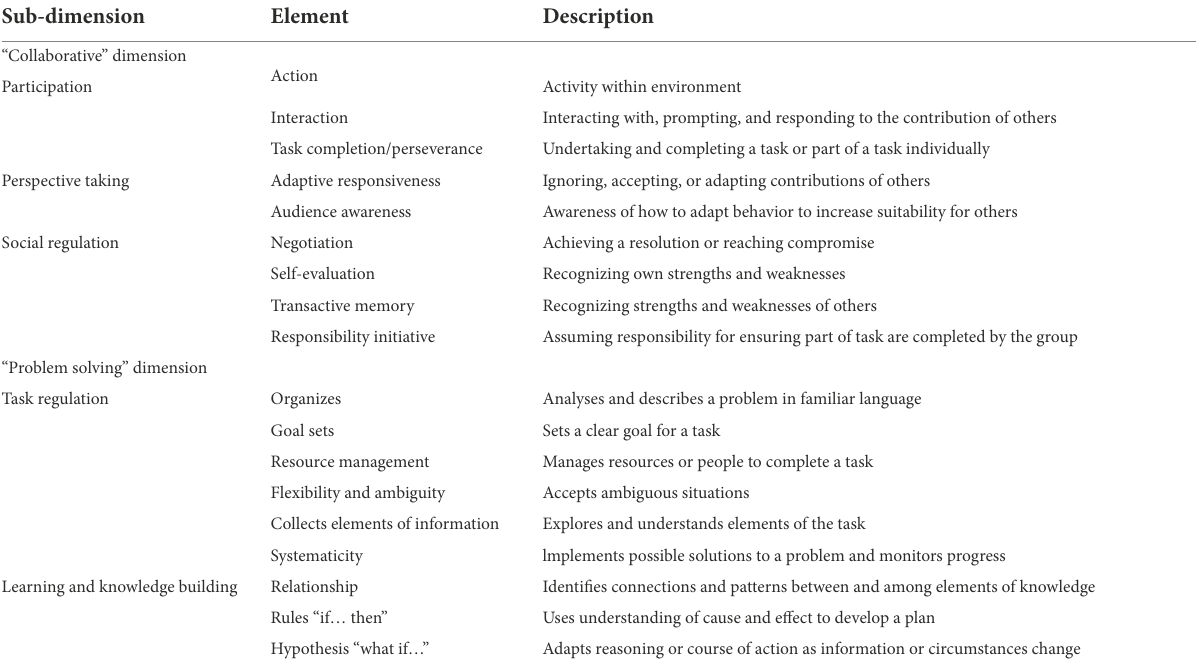
TABLE 1 Social and cognitive skills in collaborative problem solving, according to ATC21S (Hesse et al., 2015).